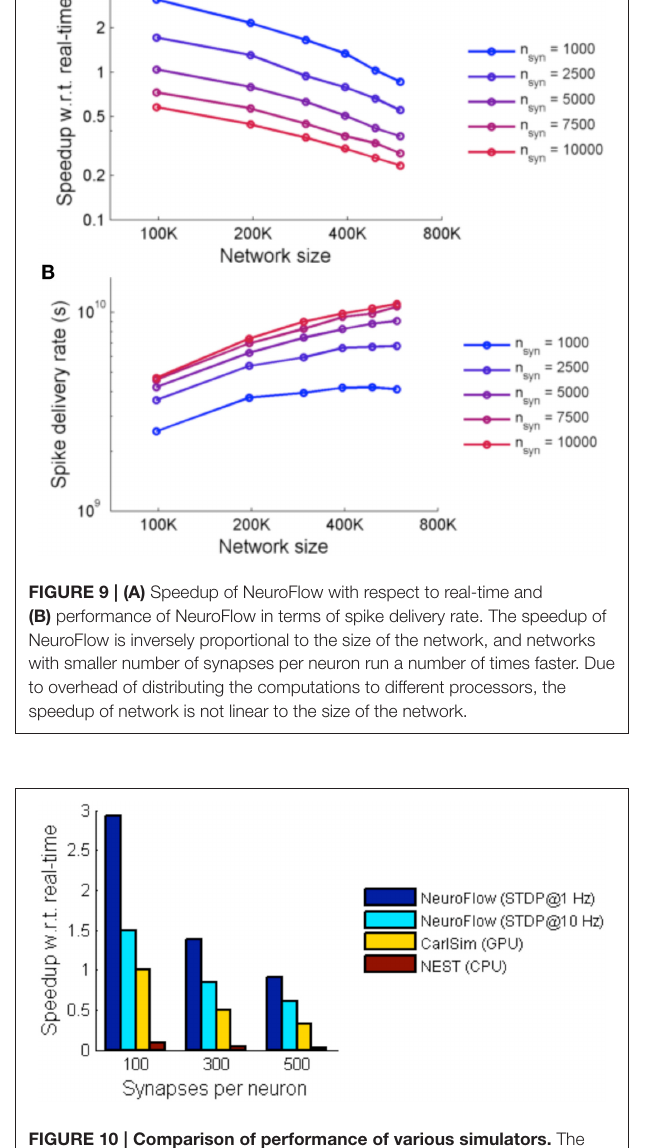
FIGURE 10 | Comparison of performance of various simulators. The performance of NeuroFlow is compared against that of a CPU-based software simulator NEST and a GPU-based simulator CarlSim. NeuroFlow is faster than GPU and CPU platforms by 2.83 and 33.6 times respectively, when simulating networks of 55,000 neurons using 100, 300 and 500 synapses, with STDP enabled using an update frequency of